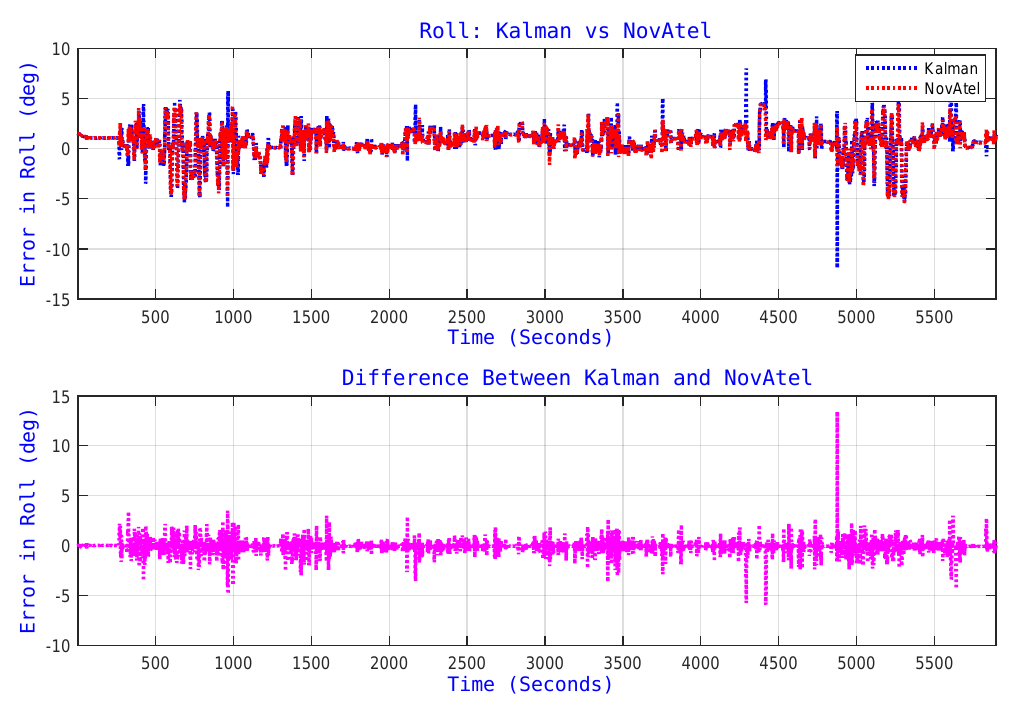
Figure 20. (Top) Performance of estimated roll angle versus the reference for the Toronto trajectory. The bottom plot shows the difference between the two